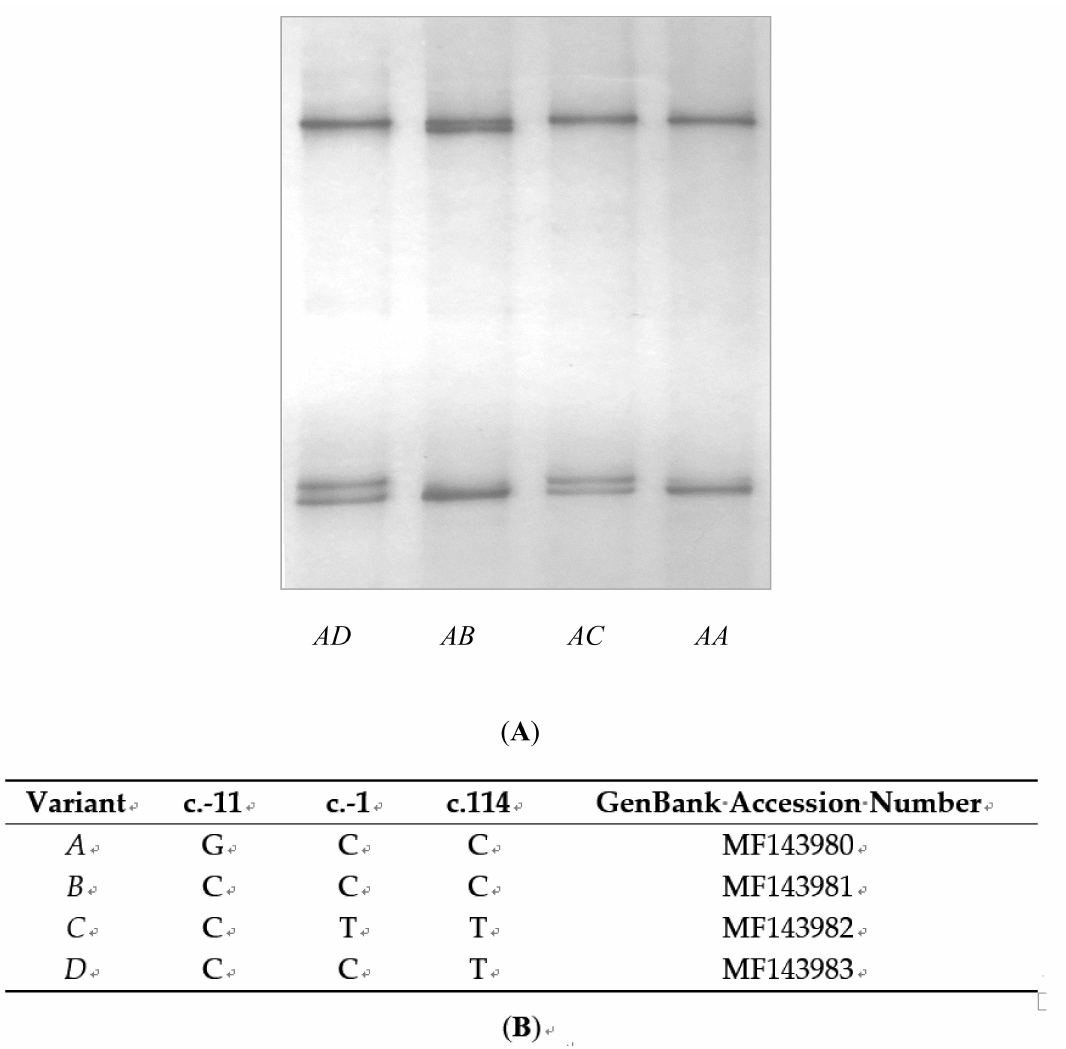
Figure 1. Variation in ovine KRTAP21-1 . ( A ) Four unique polymerase chain reaction-single stranded conformational polymorphism (PCR-SSCP) banding patterns representing four variants ( A to D ) were detected. ( B ) Three substitutions were observed in the nucleotide sequences of the variants. The ovine sequences were di ff erent from all of the sheep HGT-KAP genes identified to date, but were phylogenetically related to human KAP21-1 (Figure 2). This suggests that these ovine sequences represent ovine KAP21-1. This gene was physically located between KRTAP8-2 and KRTAP20-2 , and clustered with twelve other previously identified KAP genes on chromosome